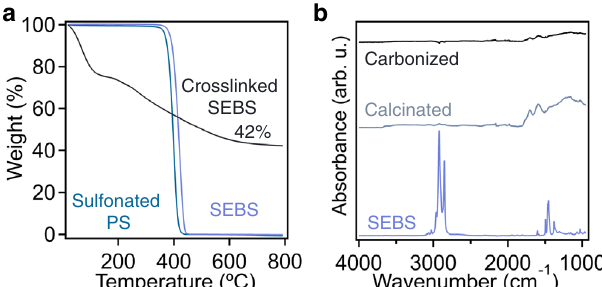
Fig. 2 | Conversion of SEBS to ordered mesoporous materials through pyr- olysis. a TGA results up to 800°C in N 2 atmosphere for neat SEBS118, sulfonated homopolymer polystyrene, and crosslinked SEBS118. b FTIR spectra of neat SEBS118,calcinatedSEBS118,andthecarbonizedproduct.Sourcedataareprovided as a Source Data fi